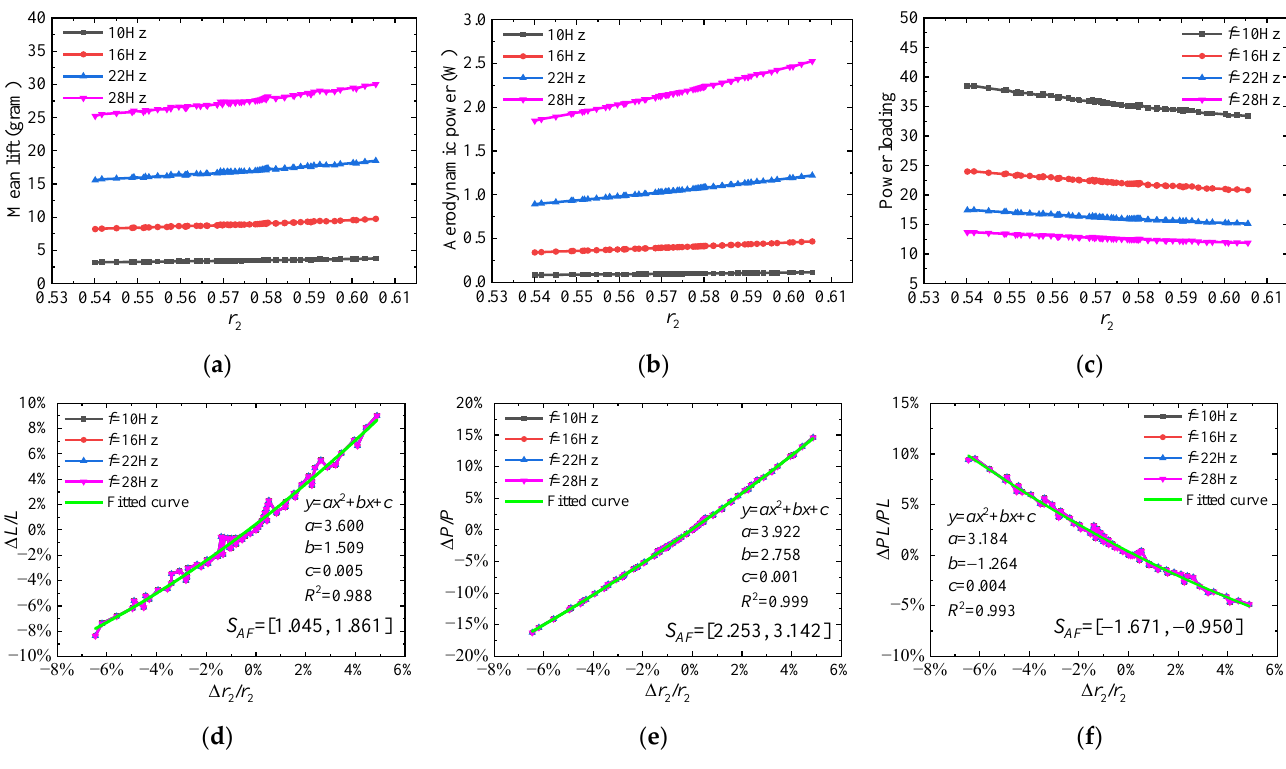
Figure 14. Sensitivity analysis for the dimensionless radius of the second moment of area r 2 base on the reordered data. All the r 2 were reordered with the corresponding force and power. ( a ) Mean lift of different r 2 . ( b ) Aerodynamic power of different r 2 . ( c ) Power loading of different r 2 . ( d ) Variation of lift vs. variation of r 2 . ( e ) Variation of aerodynamic power vs. variation of r 2 . ( f ) Variation of power loading vs. variation of r 2 .